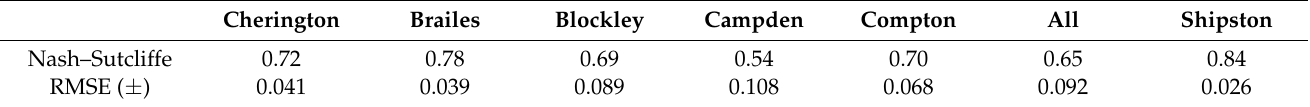
Table 3. Sensitivity analysis of models. Nash–Sutcliffe and root mean square error (RMSE) values. Cherington Brailes Blockley Campden Compton All Shipston